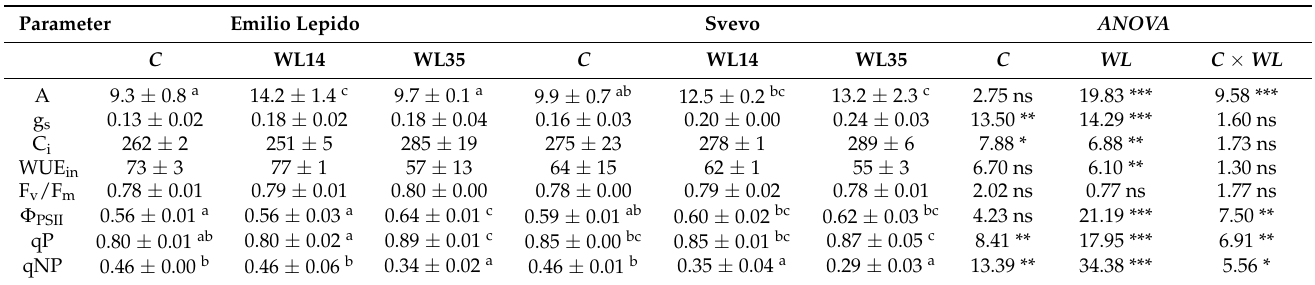
Table 2. Physiological parameters of the durum wheat cultivars Emilio Lepido and Svevo at recovery (70 days from the beginning of waterlogging) and previously subjected to 0, 14, or 35 days of waterlogging (C, WL14, and WL35, respectively). F values and p levels (***: p ≤ 0.001, **: p ≤ 0.01, *: p ≤ 0.05, ns: p > 0.05) of the two-way analysis of variance (ANOVA) for the effects of cultivar ( C ; degrees of freedom, df: 1), waterlogging ( WL ; df: 2) and their interaction ( C × WL ; df: 2) are shown. In case two-way ANOVA reveals a significant C × WL interactive effect on the specific parameter, according to Tukey’s post hoc test, different letters indicate significant differences among means ( p ≤ 0.05).